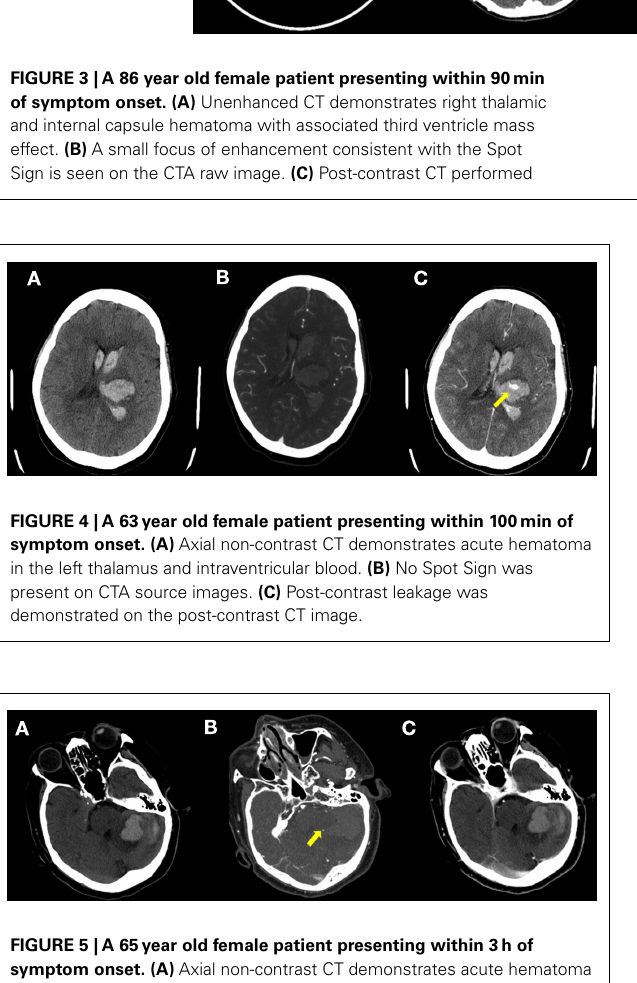
FIGURE 5 |A 65year old female patient presenting within 3h of symptom onset. (A) Axial non-contrast CT demonstrates acute hematoma in the left cerebellum. (B) Spot Sign is present at the margin of hematoma. (C) Post-contrast CT demonstrates no evidence of extravasation or post-contrast